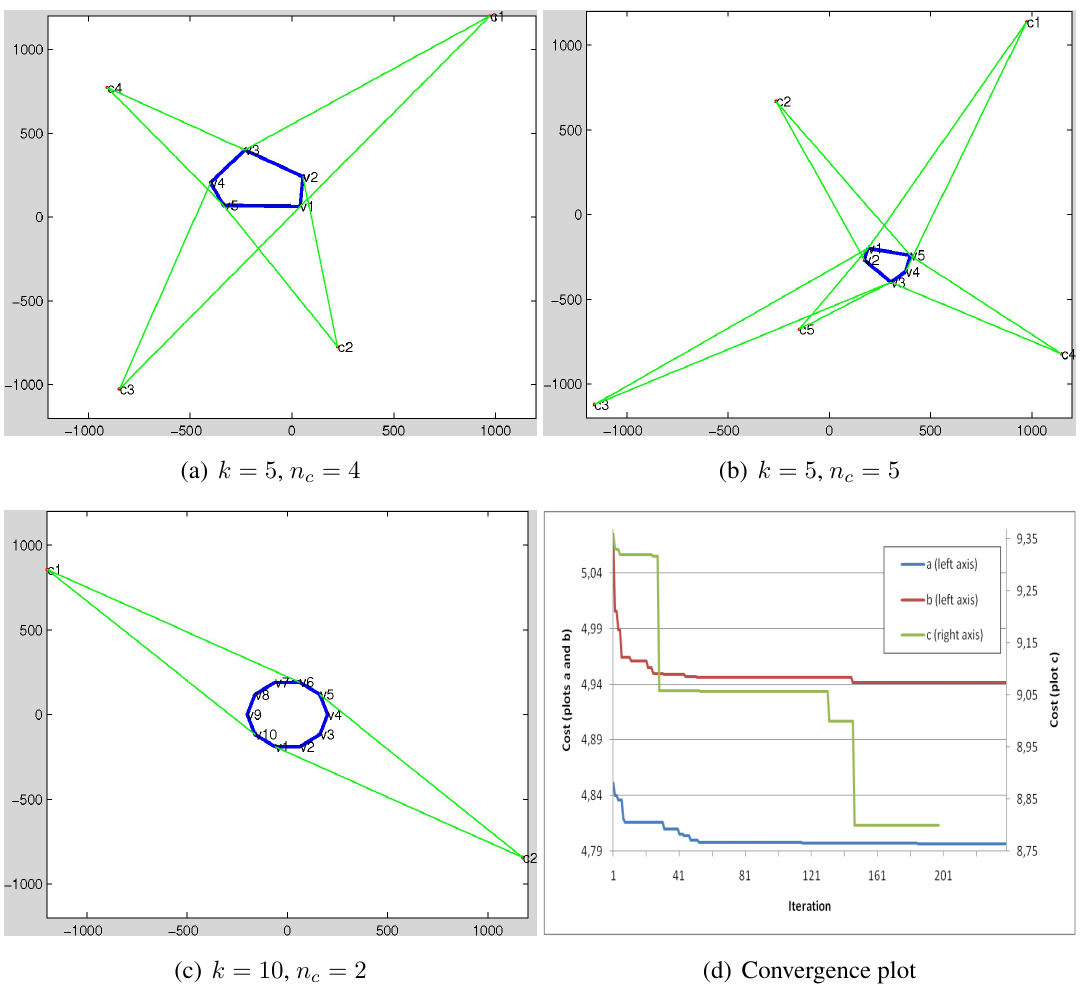
Figure 7. Results for camera placement optimization using the proposed GA. ( a – c ) depict three different samples. In each sample, a polygon with k vertices is randomly generated and the purpose of the algorithm is to search for an optimal coverage using n cameras. The convergences for the samples are plotted in ( d ). The vertical axis depicts the cost value for the fittest chromosome in each iteration, once it gets divided into the number of genes ( n ). The dimension of the search space is 1200 × 1200 cm 2 c